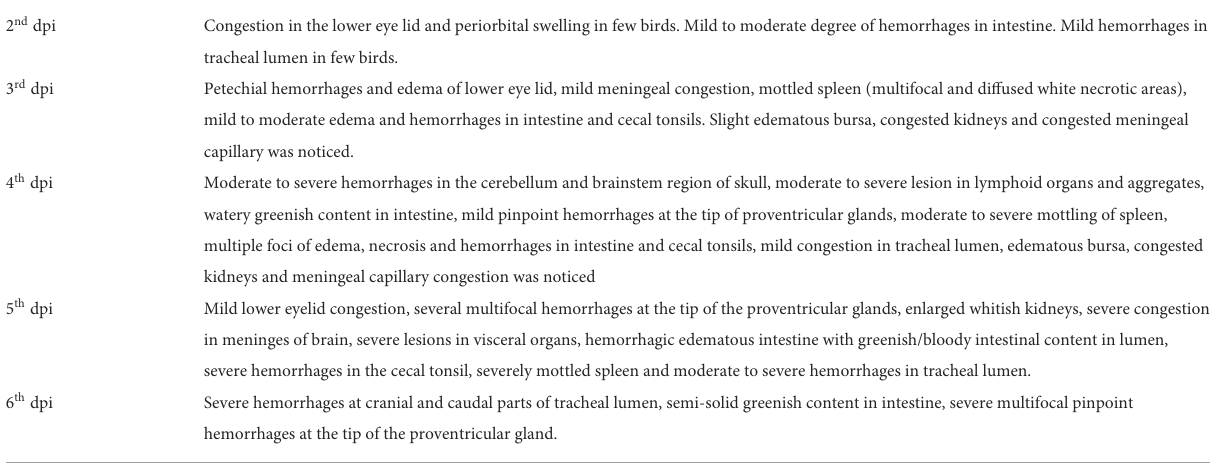
TABLE 7 Chronological appearance of gross lesions in unvaccinated challenged